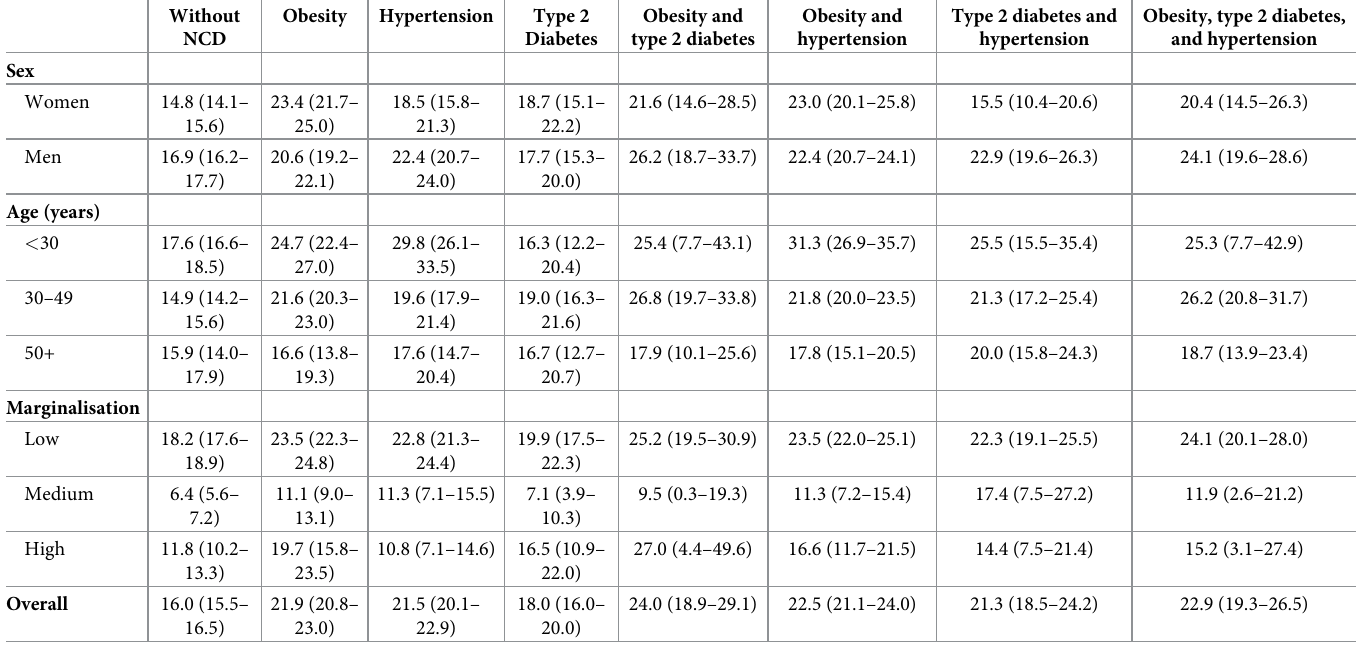
Table 5. Estimated probability of SARS-CoV-2 infection according to presence of NCDs and by sociodemographic factors. Without